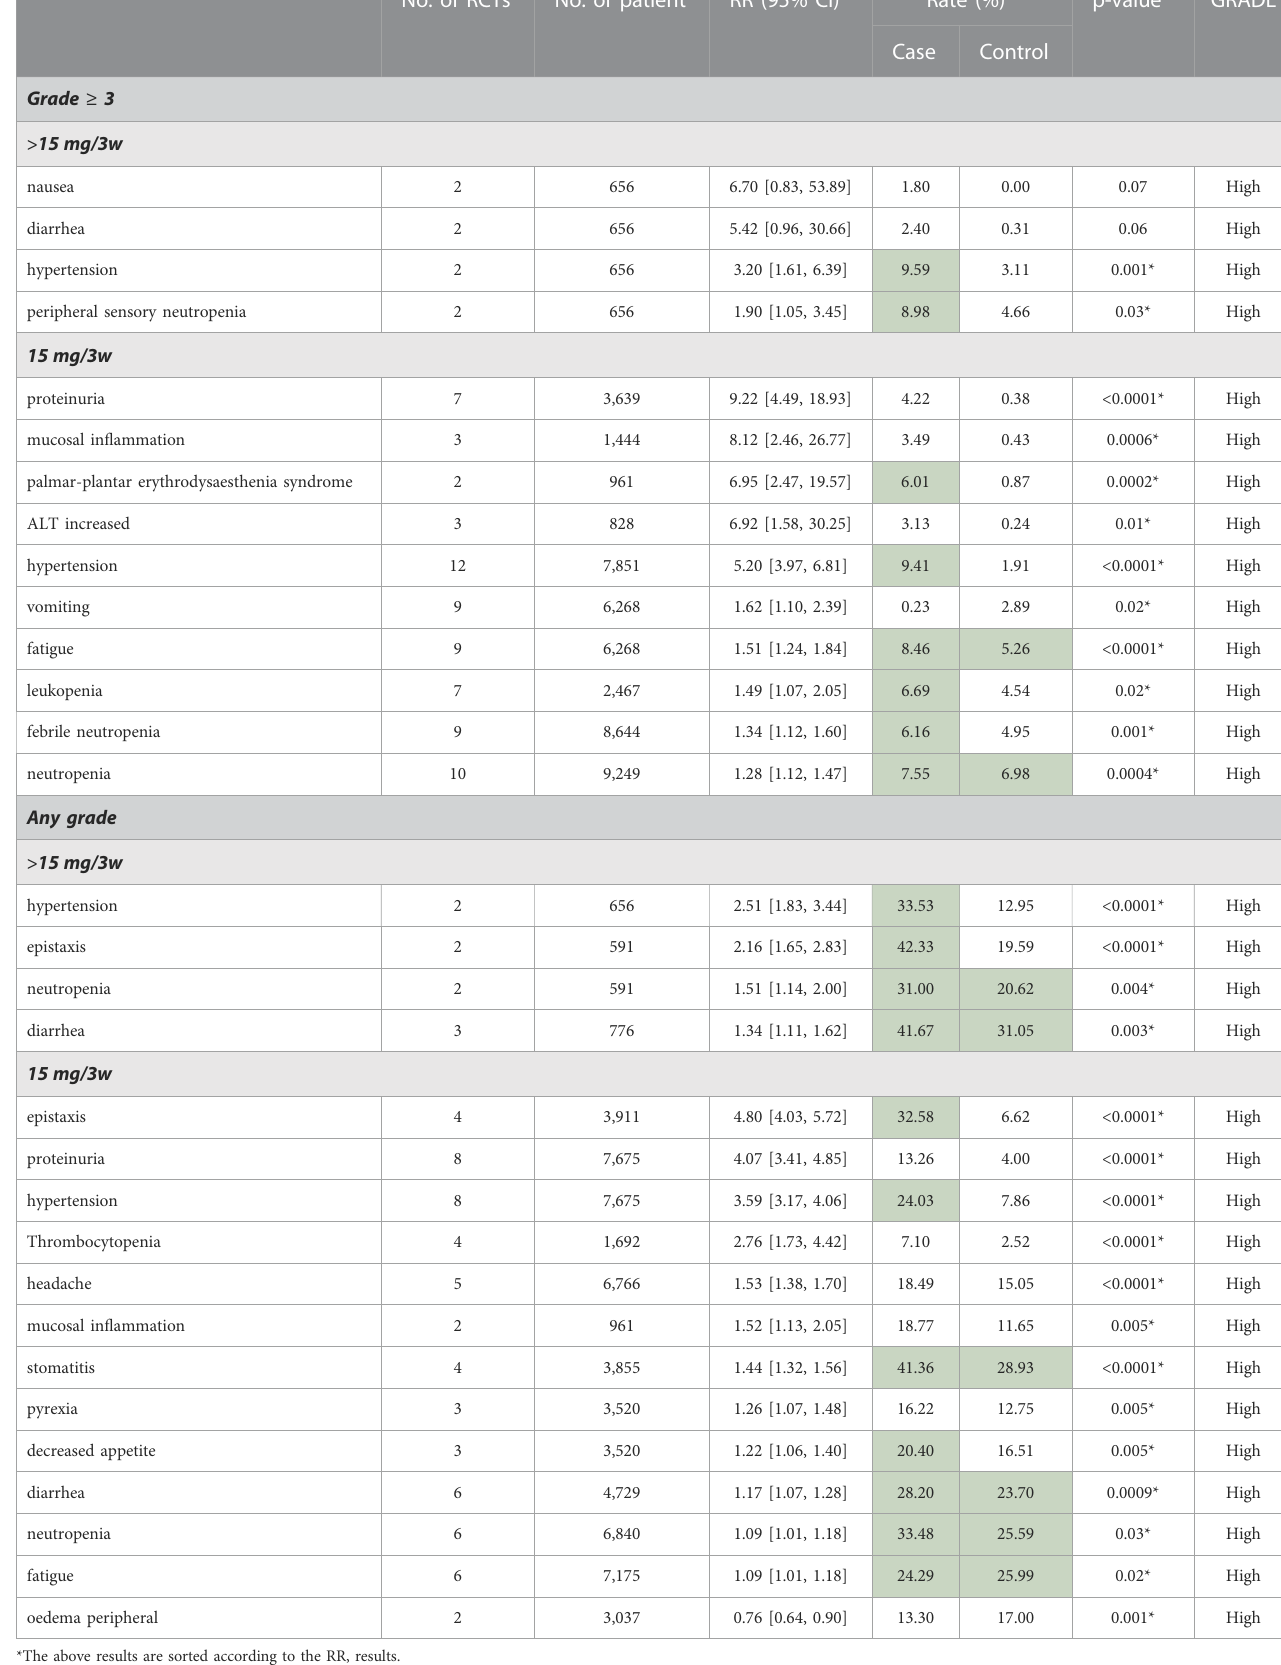
TABLE 5 Subgroup outcome of